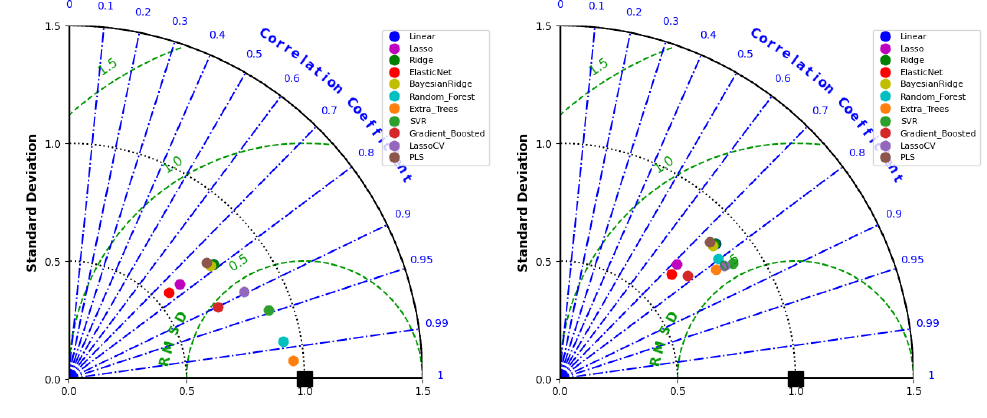
Figure 2. Taylor Diagrams for the Liverpool Bay training on the left and test on the right, comparing the the different methods used.